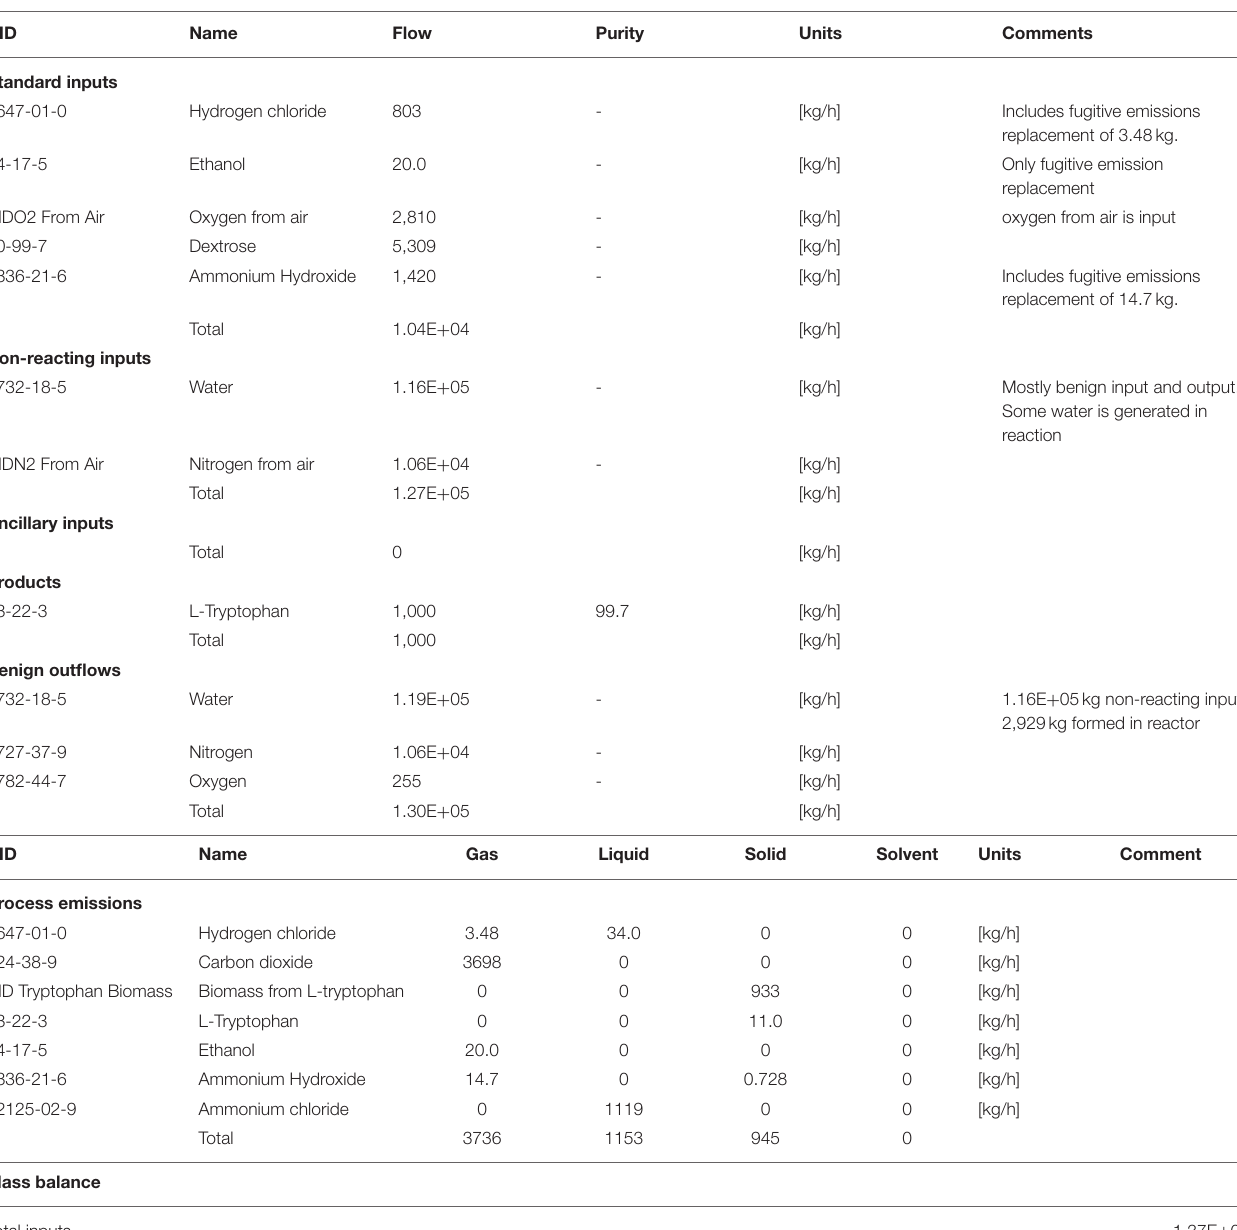
TABLE 1 | Mass balance data of all constituents involved for L-tryptophan manufacturing process (gate-to-gate) as illustrated in Figure 5 .